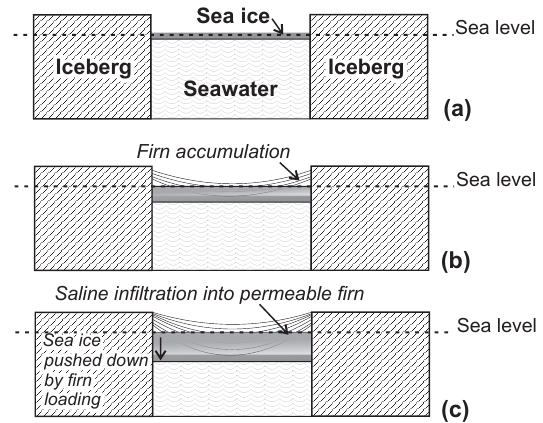
Figure 7. Westernmost section of radar profile from line 62 (Fig. 2) near Chasm 1. High-amplitude reflections interpreted as brine in- filtration horizons are observed at 26 and 39m below the surface of the ice shelf. The depth of the upper reflection coincides with sea level in the adjacent rift, suggesting horizontal migration of sea- water through porous and permeable firn recently exposed to the ocean. The lower reflection is interpreted as seawater infiltration that became frozen in place some distance upstream.